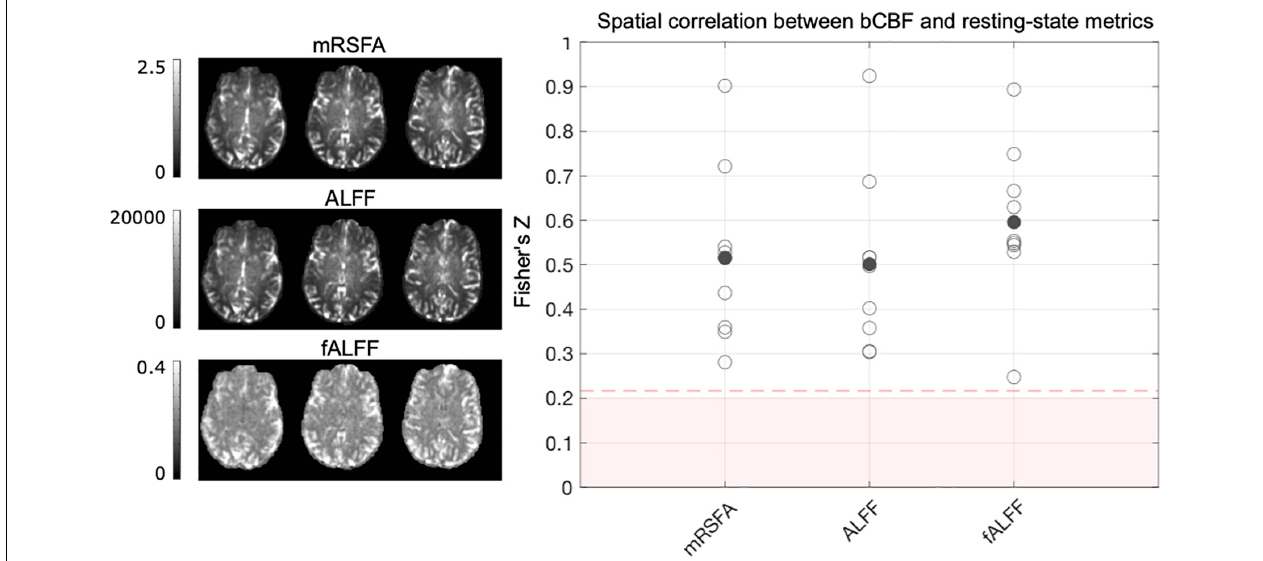
FIGURE 5 | The association between bCBF and each resting-state metric, in 96 cortical parcels, was computed for each subject, using data from the REST data segment. Maps from one example subject are displayed. A Fisher’s Z transformation is applied to the correlation values before averaging across subjects. The shaded pink box represents correlation values that would not be significant at the single-subject level, based on 96 datapoints and a critical value of 1.96 ( p < 0.05, two-tailed). When generating these correlation values for each subject, outlier parcels (based on Cook’s distance) were not included. As removing parcels reduces the degrees of freedom, the dotted pink line shows the adjusted critical value (maximum across participants and resting-state metric shown for